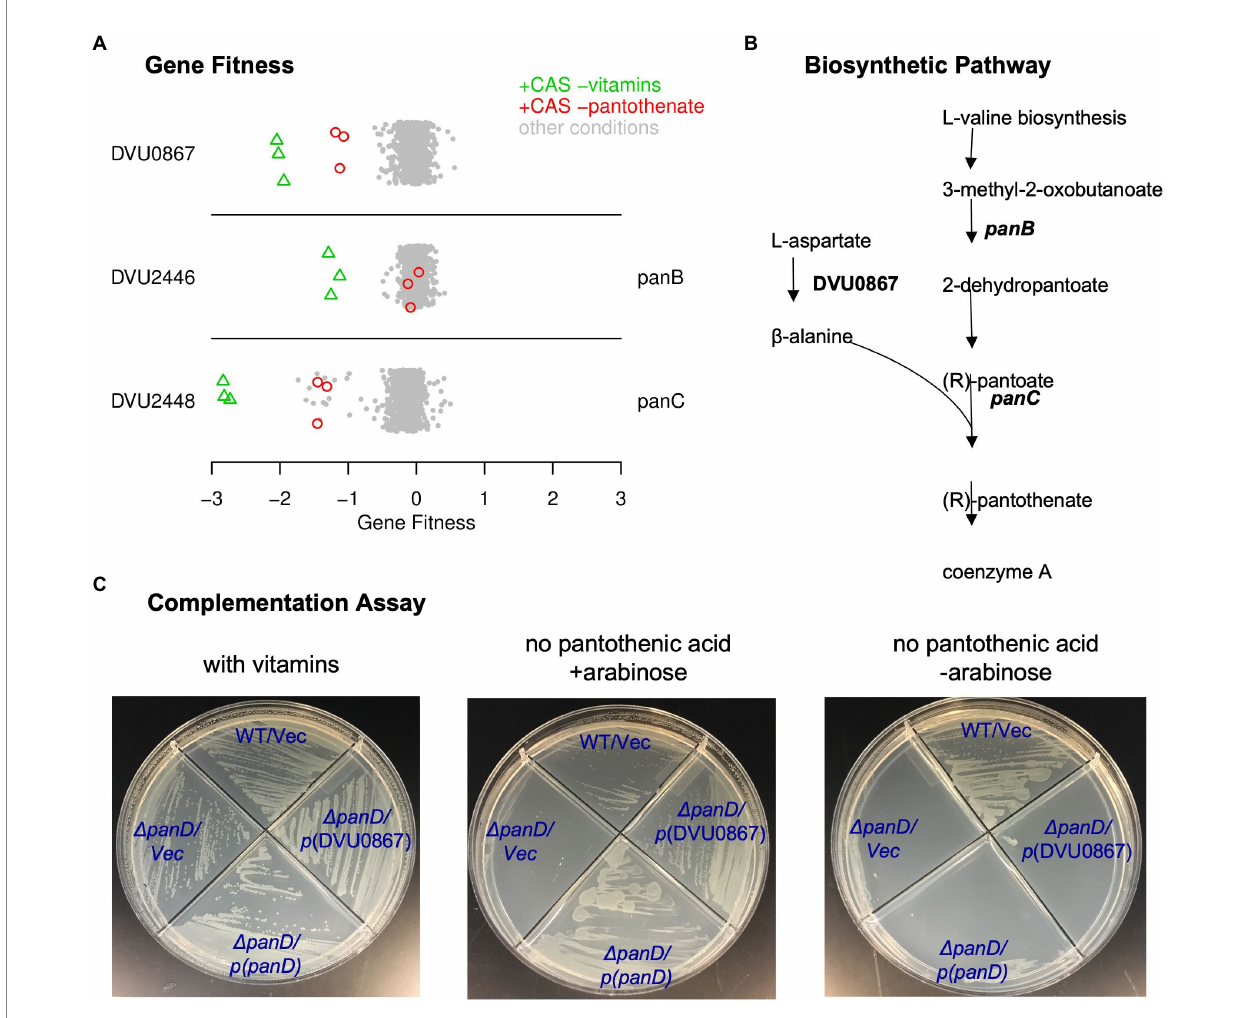
FIGURE 2 DVU0867 has L-aspartate 1-decarboxylase activity. (A) Fitness data for each gene across all 757 experiments, with pantothenate-related conditions highlighted. The y -axis is random and CAS is short for casamino acids. (B) The biosynthetic pathway for pantothenate, with key enzymes highlighted. (C) Complementation assays using an E. coli panD gene knockout strain that is defective in pantothenate biosynthesis and lacks aspartate 1-decarboxylase activity. Indicated genes were cloned upstream of an arabinose inducible promoter. Vec is an empty vector